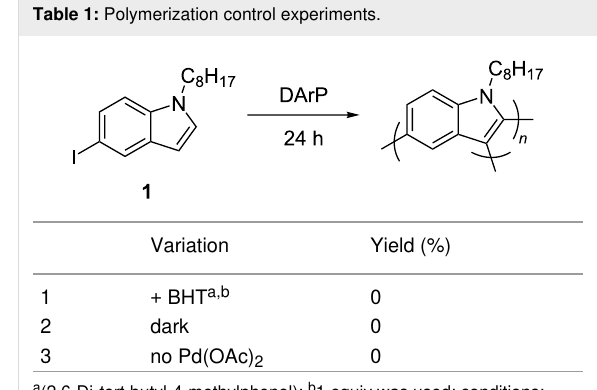
Figure 2: MALDI–TOF MS of PIn, indicating octylindole repeat units with three different types of end groups. These include 2-nitrophenyl, iodine, and hydrogen.